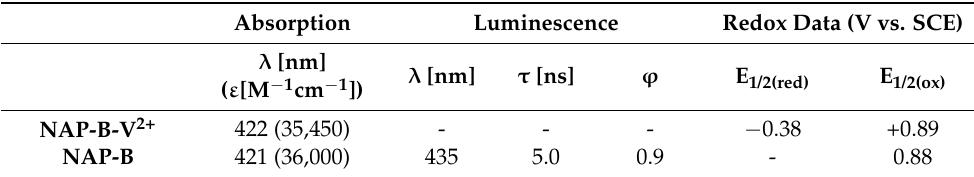
Table 1. Spectroscopical and electrochemical data of both the dyad NAP-B-V 2+ and the model compound NAP-B.